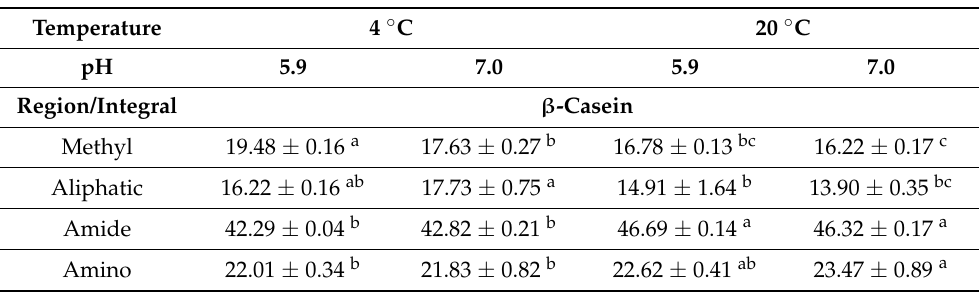
Table 2. Total percentage areas peaks in different regions for β -casein in NMR including methyl, aliphatic, amide and amino region. The difference in the percentage is presented for β -casein at temperature of 4 and 20 ◦ C and pH of 5.9 and